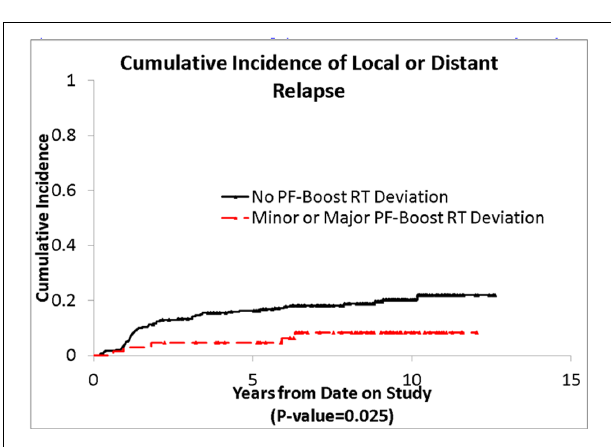
Forty percent of patients had “inaccuracies” equivalent to our “minor deviations” in the region of the frontal lobe, and 20% in the middle cranial fossa. Including dose, more than half the evaluable patients had a major deviation, and these were not asso- ciated with a worse survival. However, of interest, patients with zero to one major deviation as compared to those with two to four major deviations, had a 5-year EFS of 71.0 vs. 61.8% ( p = 0.30), and 5-year OS was 76.6 vs. 69.9% ( p = 0.22),